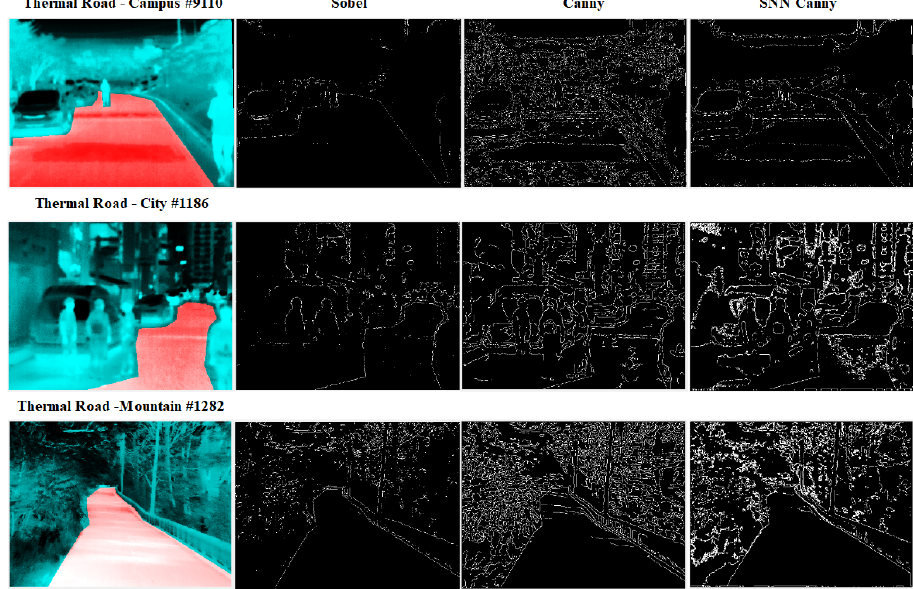
Figure 5. A comparison of edge detection by Sobel, Canny, and SNN Canny edge detectors for images from thermal road